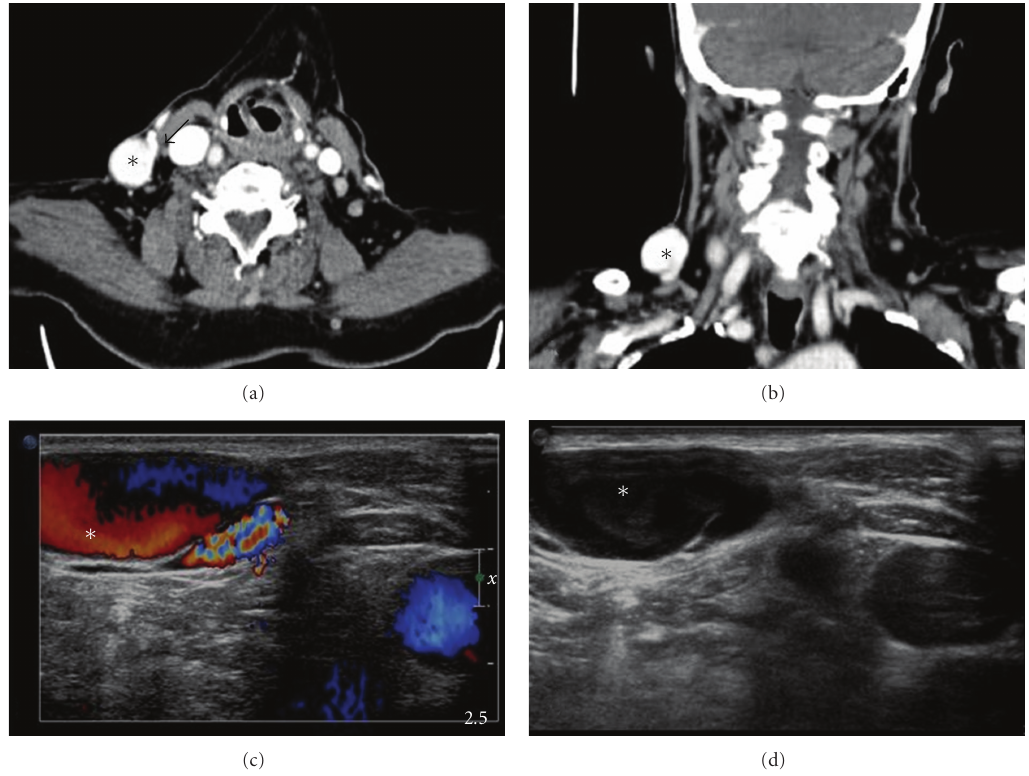
Figure 2: Axial (a) and (b) coronal Multidetector Computed Tomography (MDCT) images following intravenous contrast administration and color Doppler (c) and gray scale (d) ultrasound images of an external jugular vein aneurysm. Ultrasound and MDCT showed the presence of a cystic mass (asterisks) communicating with a short neck (arrow) with the external jugular vein. The lesion presented with venous flow on colour Doppler US examination and intense contrast enhancement on